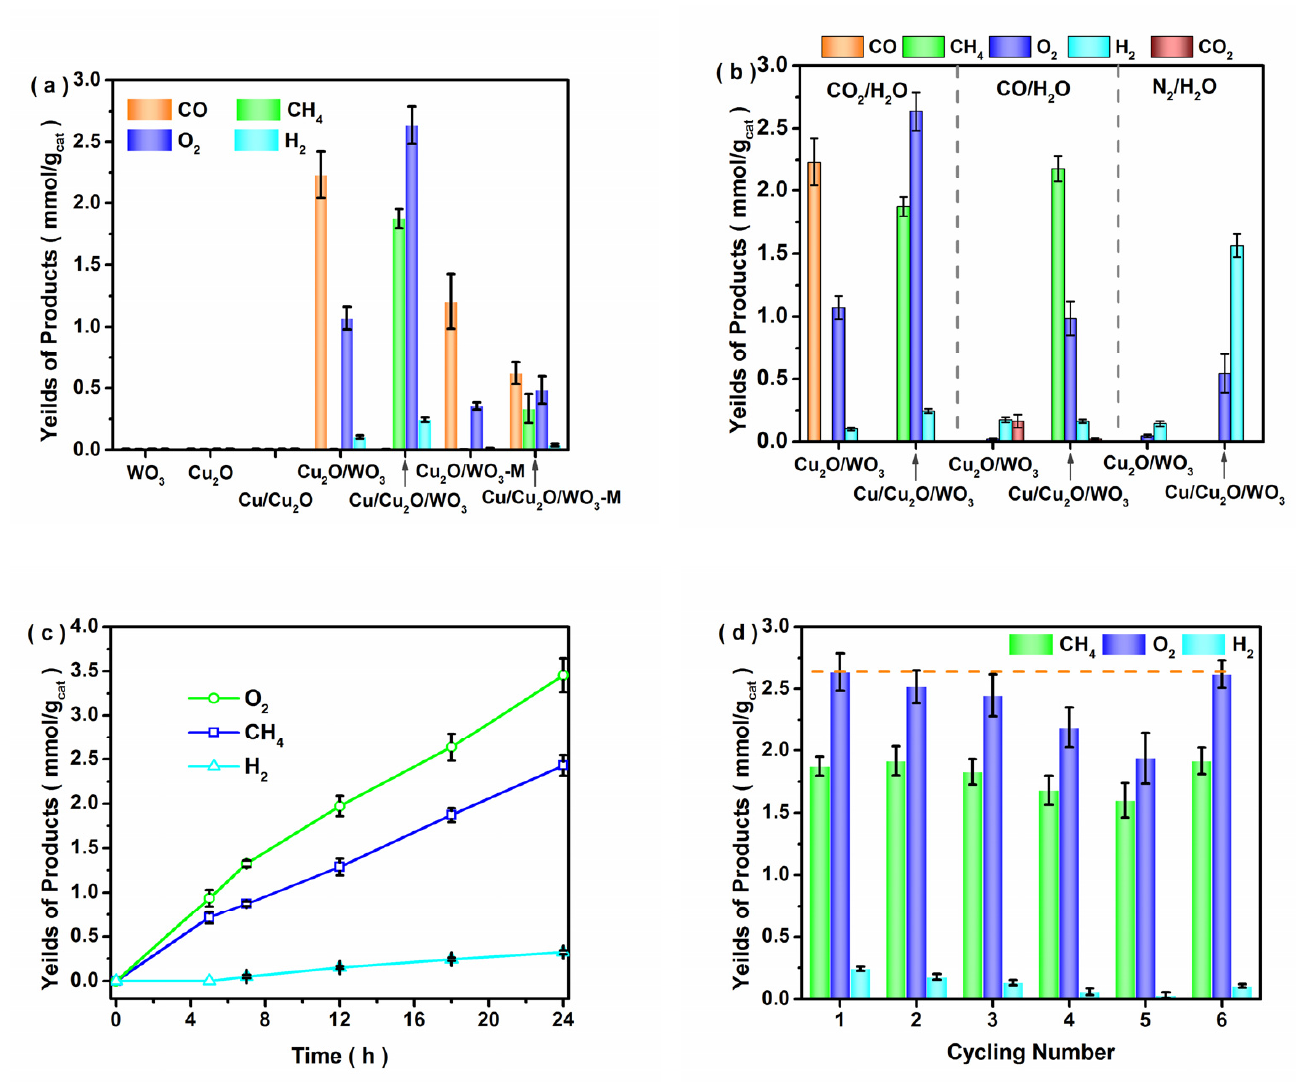
Figure 6. Photocatalytic performances of CO 2 reduction with water vapor after 18 h of visible light irradiation (>400 nm) over different samples ( a ), photocatalytic activities under different atmospheres ( b ), the yields of products for the Cu/Cu 2 O/WO 3 composite in the CO 2 /H 2 O atmosphere within 24 h of irradiation ( c ) and product yields for the Cu/Cu 2 O/WO 3 catalyst in cycling experiment under visible light irradiation for 18 h ( d ).